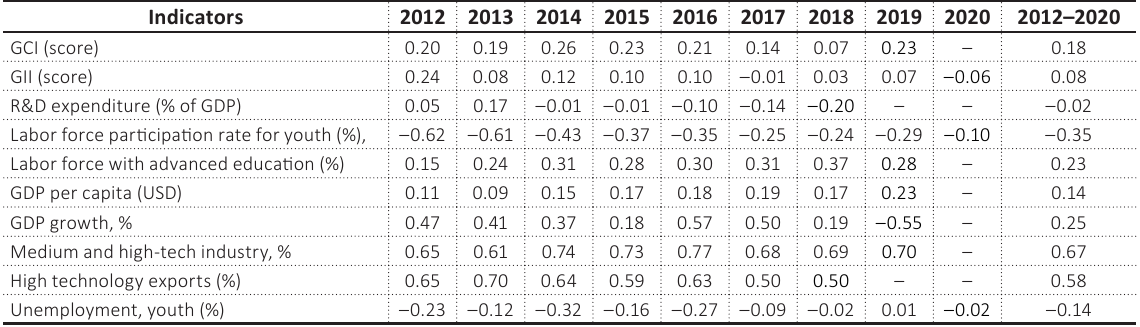
Table 7. Correlation indices between the higher education development index (GII component) and selected indicators of economic development